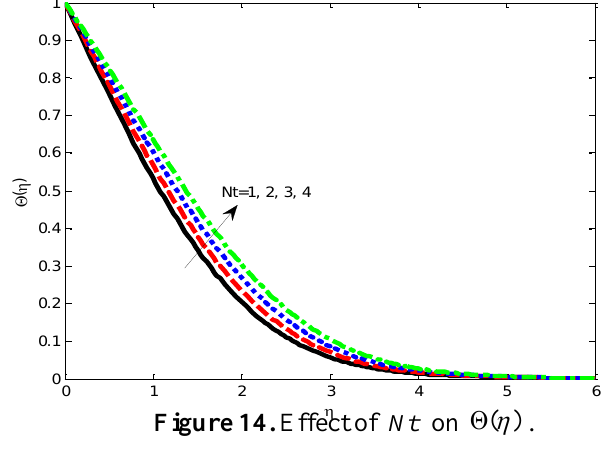
Figure 14. Effect of Nt on ( ) 